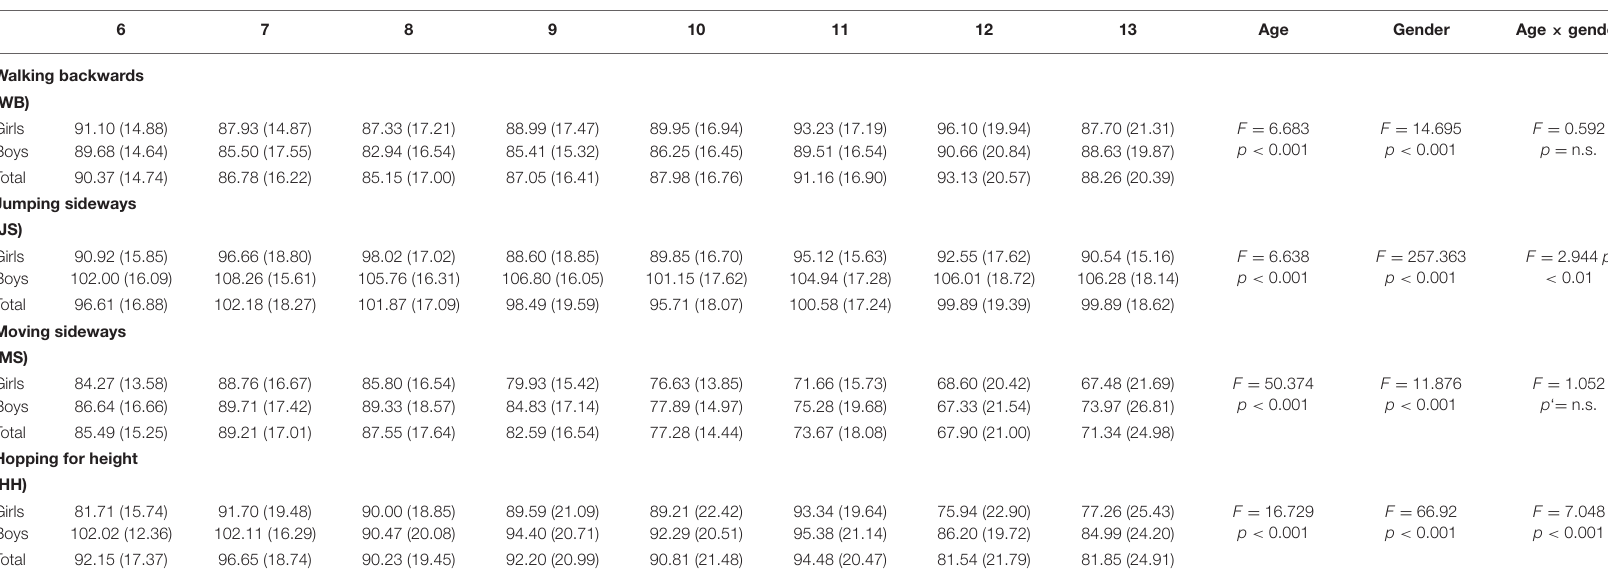
TABLE 4 | Standardized values (mean ± standard deviation) of the four KTK subtests (walking backwards, moving sideways, jumping sideways, and hopping for height) for gender and